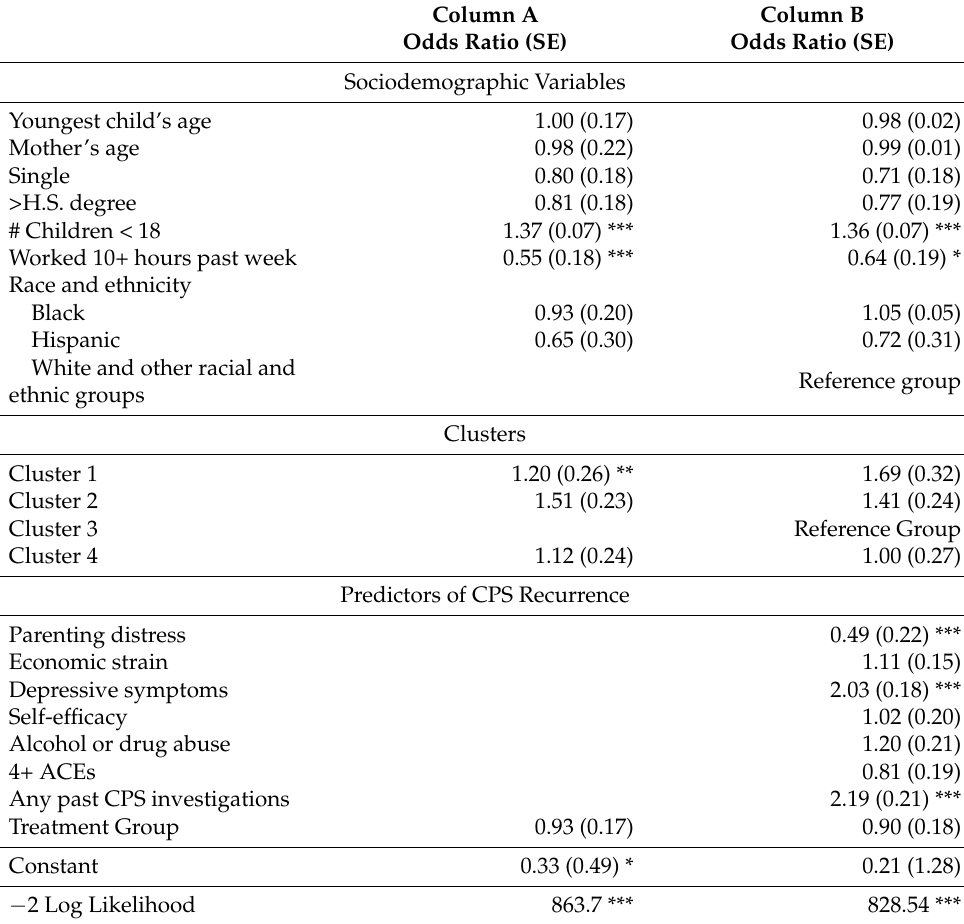
Table 4. Logistic Regression Predicting CPS Recurrence (N =